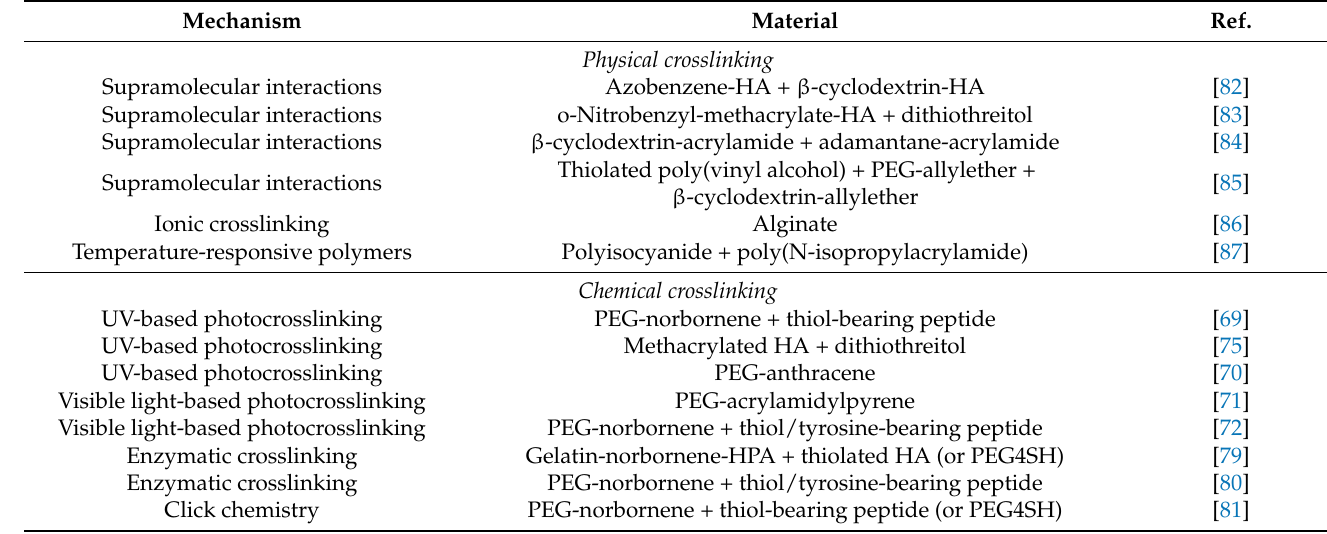
Table 1. Chemistry for dynamic crosslinking of hydrogels to mimic tissue